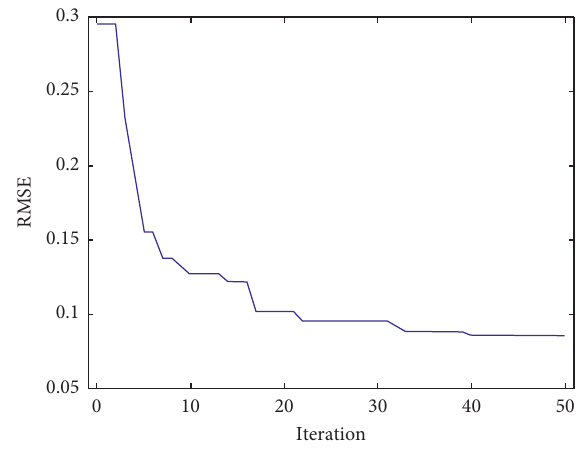
Figure 5: RMSE versus iterations. Table 2: The obtained hyperparameters of RF.